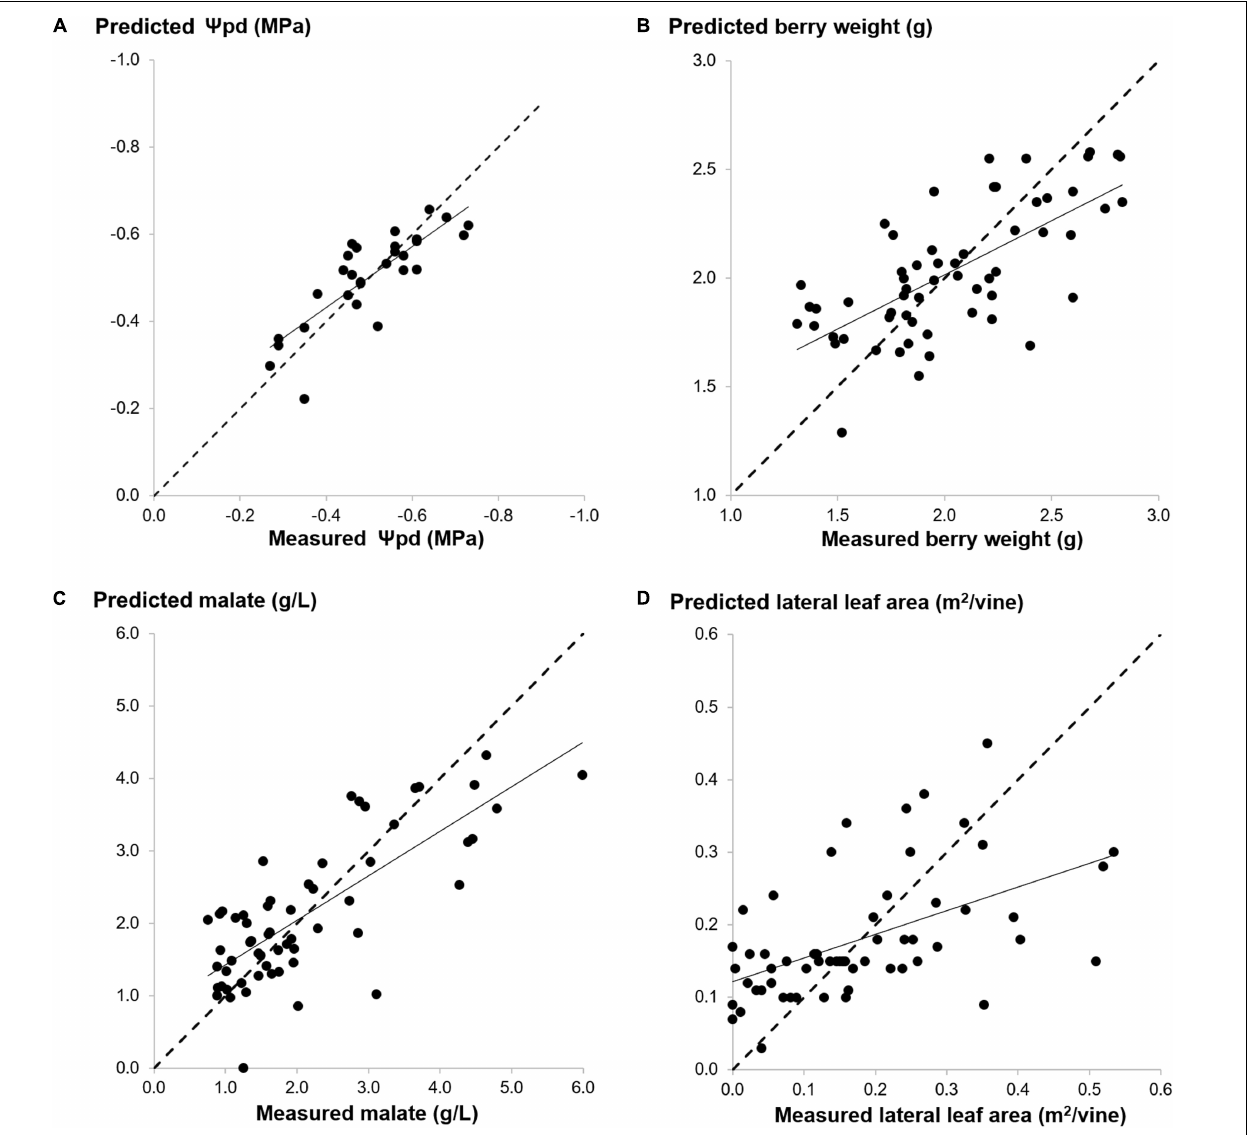
FIGURE 4 | Predicted values vs. ground-based measurements of the best calibration performances of multivariate models achieved for each biophysical parameter group: (cid:57) pd for ecophysiological Y [ (A) , R 2 CV = 0.65, RMSECV = 0.07 MPa], Bwt for productive Y [ (B) , R 2 CV = 0.46, RMSECV = 0.30 g], Malate for qualitative Y [ (C) , R 2 CV = 0.59, RMSECV = 0.78 g/L], LLA for vegetative Y [ (D) , R 2 CV = 0.31, RMSECV = 0.11 m2/vine].The dotted line indicates a regression with slope =